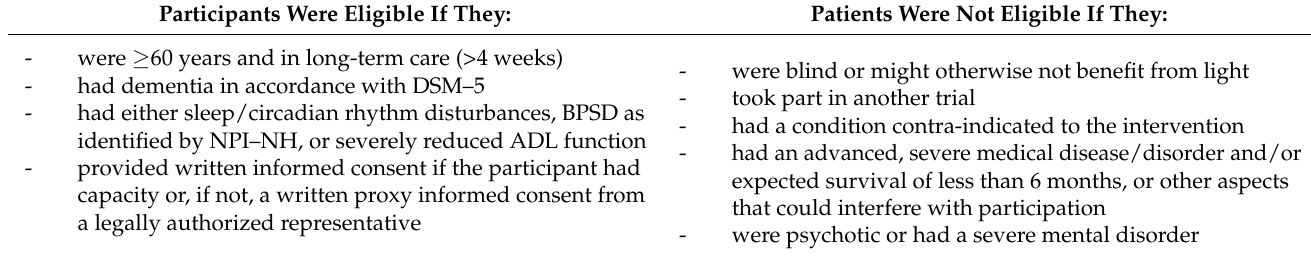
Table 1. Study inclusion and exclusion criteria.